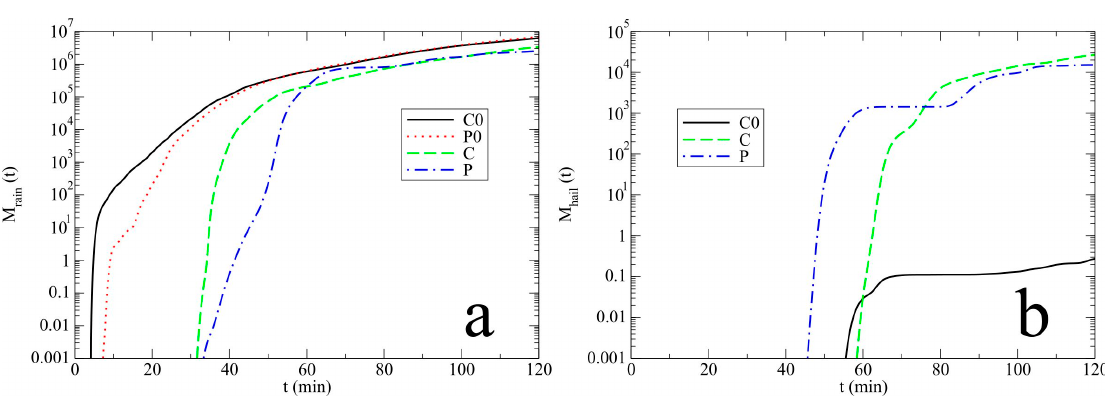
and is shifted slightly downwind.